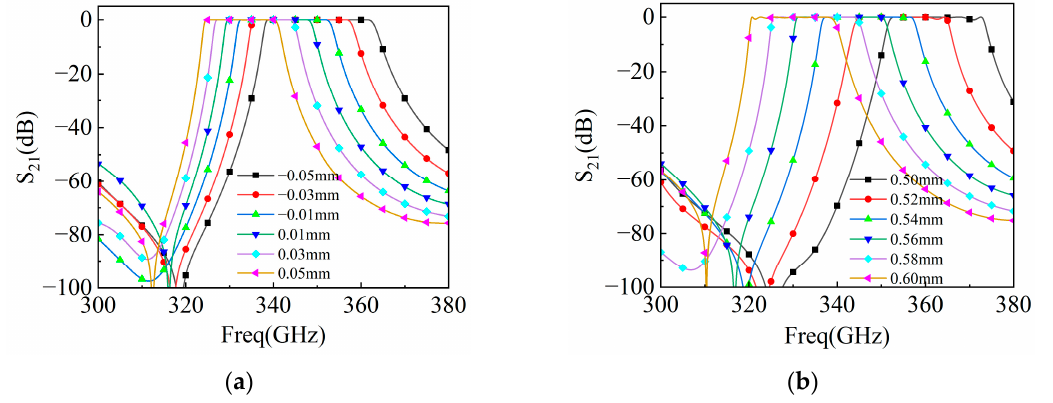
Figure 7. S 21 changes with cavity resonator parameters. ( a ) Length L 1~ L 4 of cavity resonator; ( b ) width d of cavity resonator.